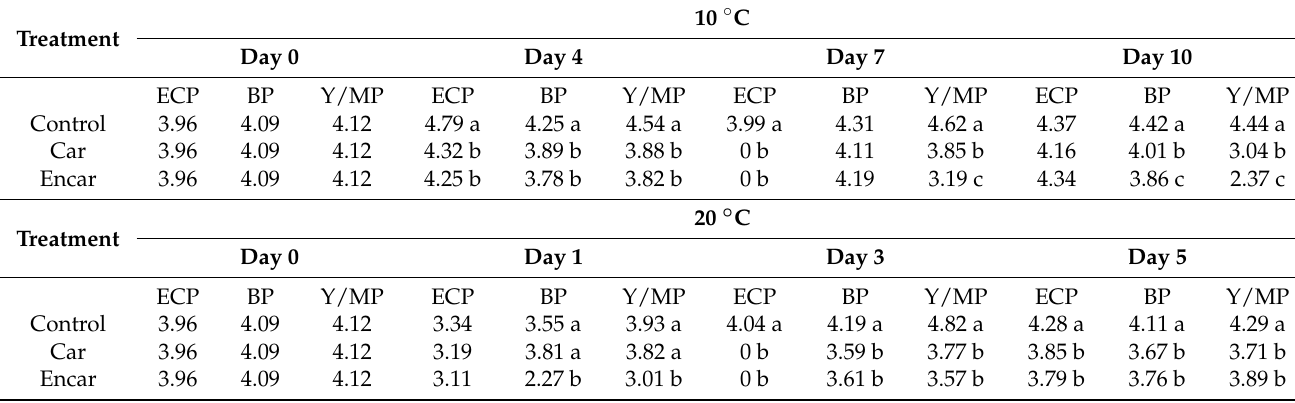
Means followed by a different letter in the same column within a storage temperature were not significantly different using the Student’s t test ( p < 0.05, n = 3). ECP: population of E. coli ; BP: population of mesophilic aerobic bacteria; Y/MP: population of yeasts and